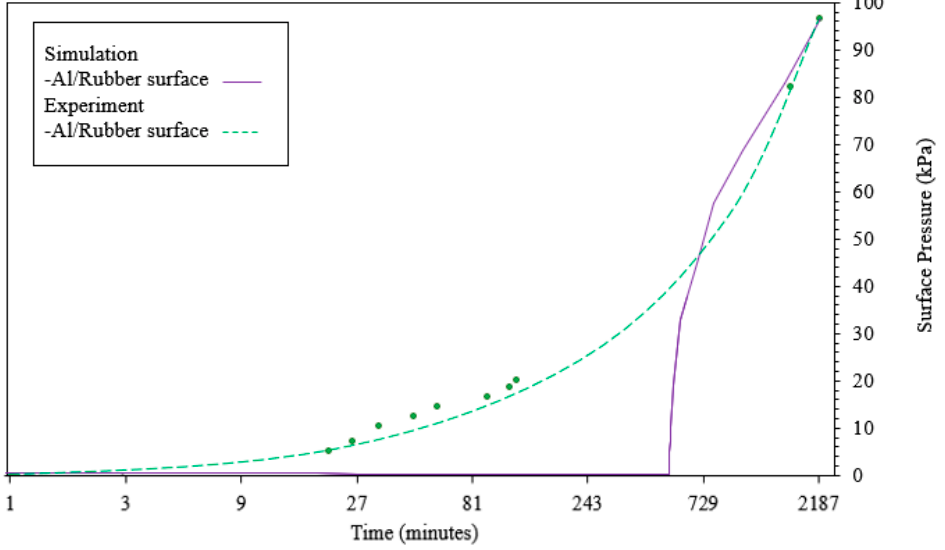
Figure 9. Comparison of simulated pressure change with experimental data.